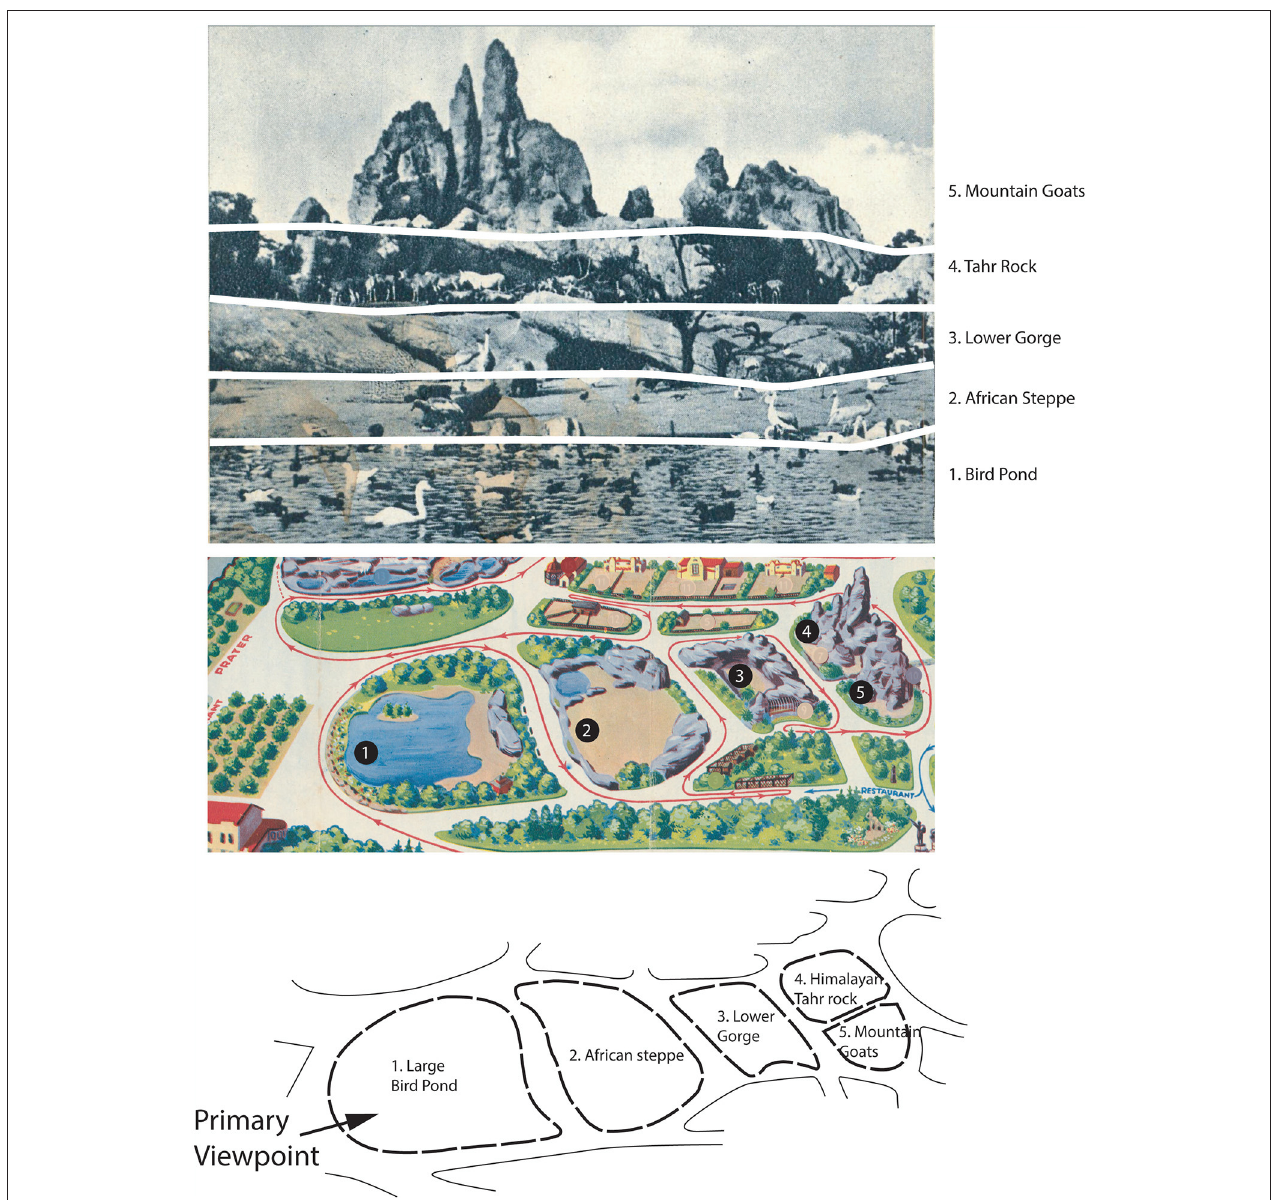
FIGURE 9 | Zoo enclosures are artificial, theatrical spaces where animals are put on display. Only the form of the food webs to which the animal belongs is illustrated; its sole function is to represent nature. The Hagenbeck Tierpark Zoo near Hamburg, Germany (constructed 1907) was the first zoo to replace cages with open enclosures and moats and berms to manage animal. The African exhibits illustrate potentially interacting species whose functions in their ecological community are entirely lost. People standing at the primary viewpoint (indicated in the bottom panel) see an assemblage of species that each occupy their own enclosure. This is an example of form-driven aesthetics created by perspectival viewpoints. The theatrical arrangement follows functional considerations related to vantage points and perspective (top and middle panels). Image sources: (Top) Carl Hagenbeck’s Tierpark, Hamburg. 1935. Die Entwicklung des Hauses Carl Hegenbeck (https://www. davidrumsey.com/luna/servlet/detail/RUMSEY~8~1~299571~90070511:Text--Die-Entwicklung-des-Hauses-Ca; CC BY-NC-SA 3.0); Diagram by Alexander Felson; (Middle) Plan, Carl Hagenbecks Tierpark, Altona/Stellingen/Hamburg,